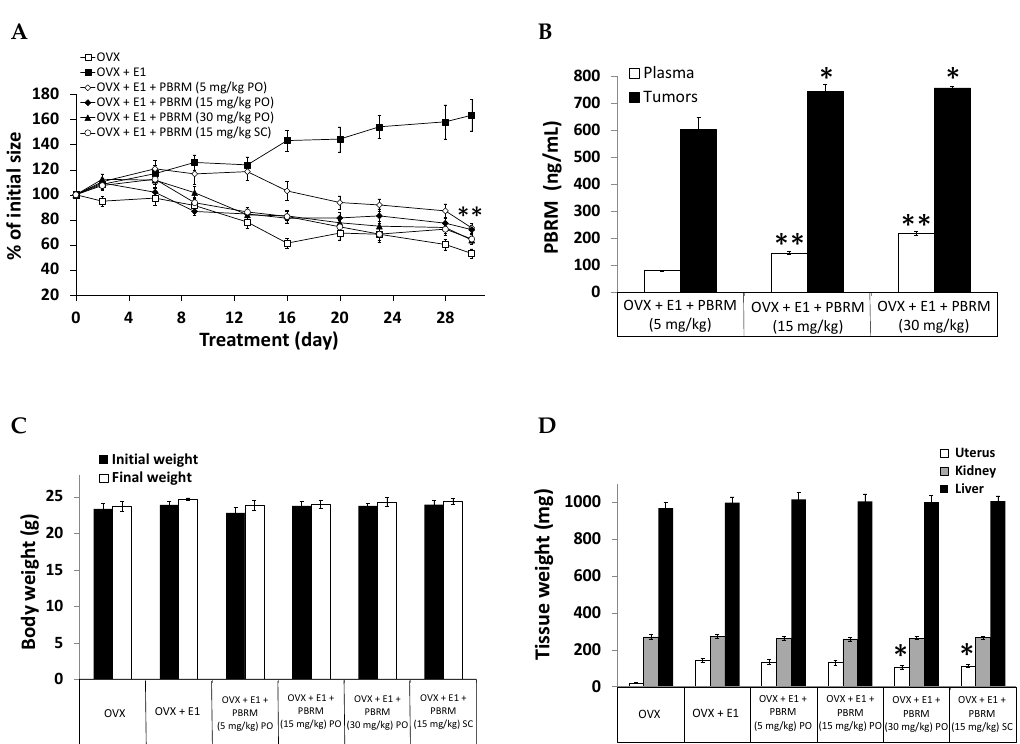
Figure 4. ( A ) Inhibition (%) of breast cancer tumor growth (T-47D xenografts) stimulated by E1 injected subcutaneously (SC) six days a week in nude mice. The inhibitor PBRM was solubilized in sunflower oil:EtOH (92:8) and administered PO (gavage) or SC in propylene glycol:EtOH (92:8) six days a week. (**) p < 0.01 vs. OVX + E1 at 16, 20, 23, 28 and 30 days. ( B ) Plasma and tumor concentrations of PBRM at the end of the protocol are reported in ( A ) (3 h after the last PBRM administration). (*) p < 0.05 and (**) p < 0.01 vs. OVX + E1 + PBRM (5 mg/kg). ( C ) Body weight of mice from the protocol reported in ( A ). No significant difference between PBRM-treated groups and untreated group (OVX + E1). ( D ) Uterus, kidney and liver weights of mice from the protocol reported in ( A ). No significant difference between PBRM-treated groups and untreated group (OVX + E1) except for uterus (*) p < 0.05.